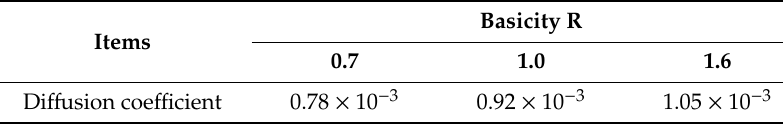
Table 3. Di ff usion coe ffi cient of sulphur in alloy melt (cm / s).